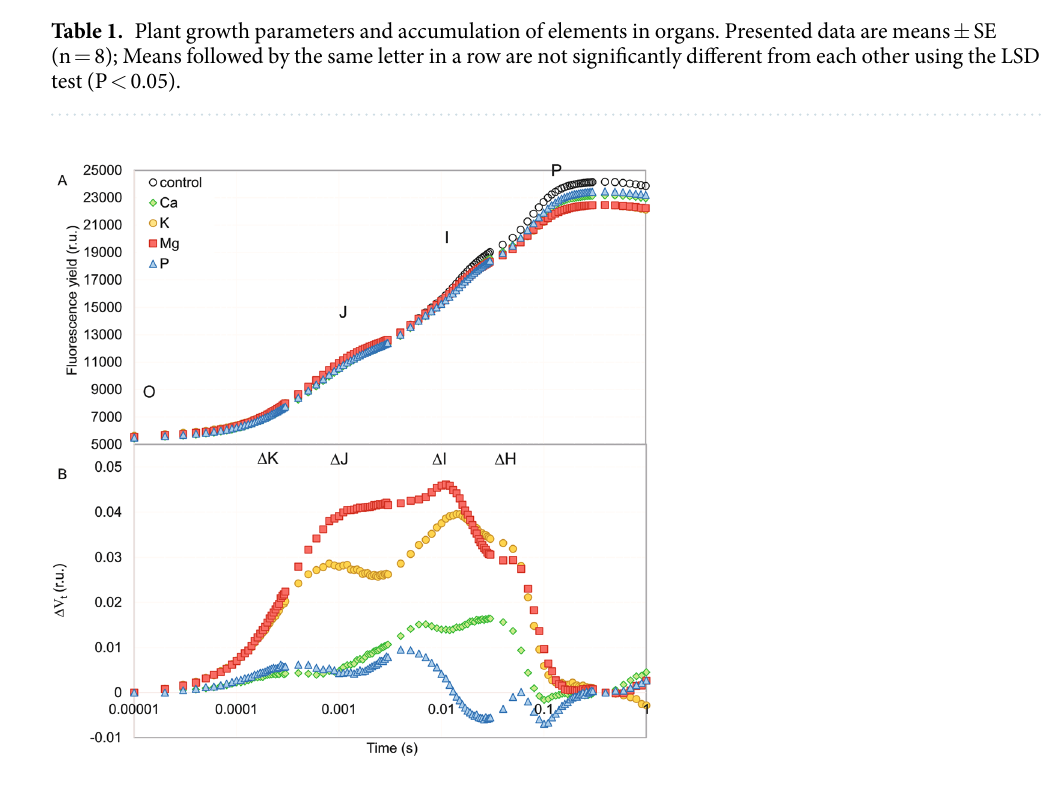
Figure 1. Chlorophyll a fluorescence induction curves of the Zea mays L. treated with different macronutrient deprivation ( A ) and the effect of these deprivation on the relative variable fluorescence ( Δ V t = ((F t − F 0 )/F v ) − V t _control) ( B ). For Δ V t analysis, the fluorescence of the control leaves was the reference and equaled 0. Values are means (n =